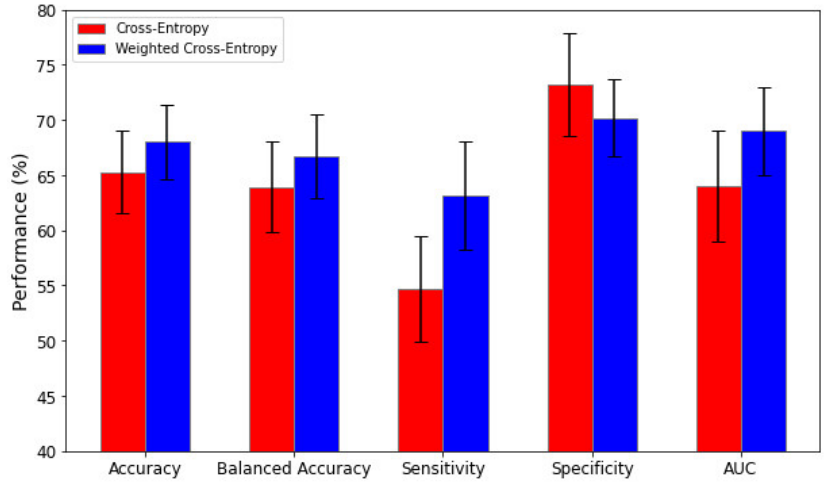
Figure 6. The model performance comparison of the graph convolutional network model using cross-entropy and weighted cross-entropy loss functions.